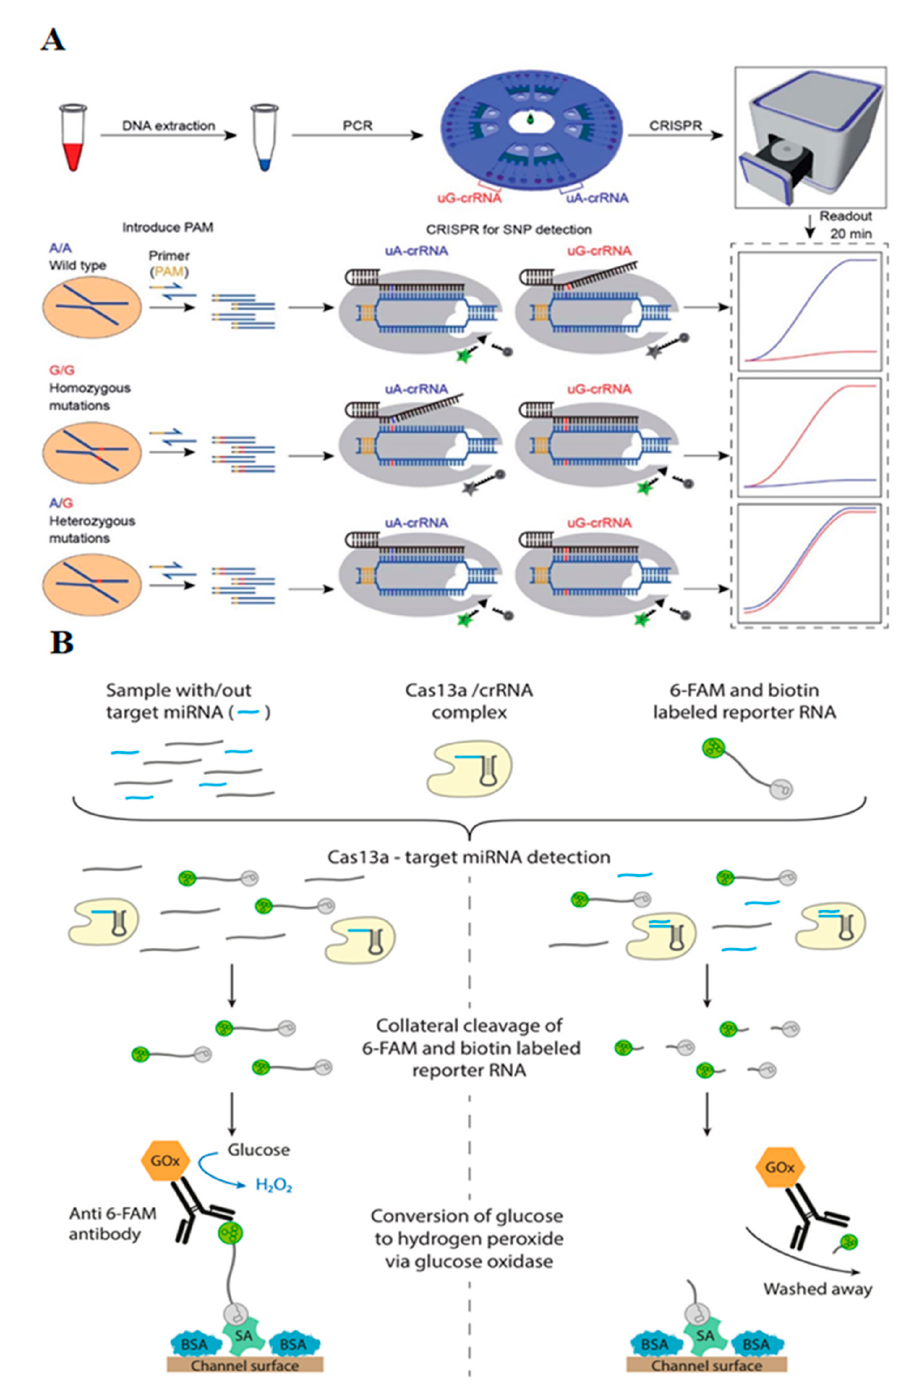
Figure 5. ( A ) Schematic illustration of CRISPR-based SNP detection chip [27]. ( B ) CRISPR-based miRNA detection for electrochemical signal readout [25]. Figures reprinted with permissions.